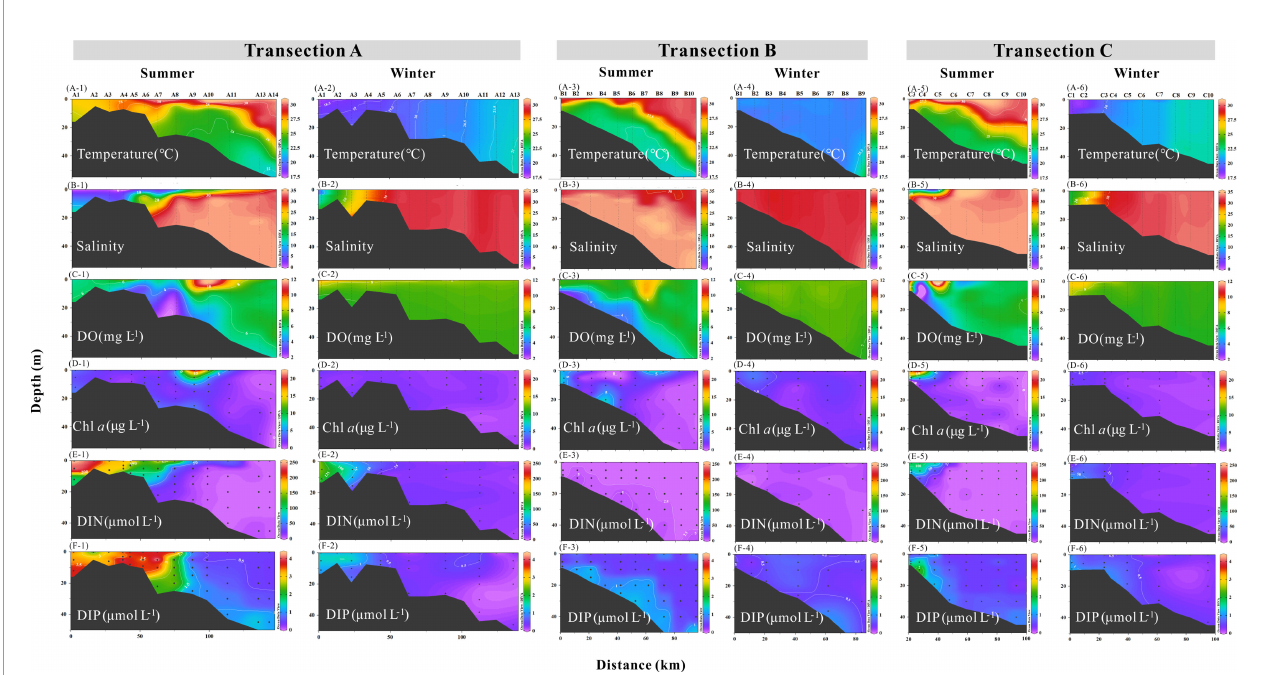
FIGURE 2 | Vertical distributions of temperature ( A , °C), salinity (B) , DO ( C , mg L -1 ), Chl a concentration ( D , m g L -1 ), DIN ( E , m mol L -1 ), and DIP ( F , m mol L -1 ) along the transections A , B , and C in summer and winter